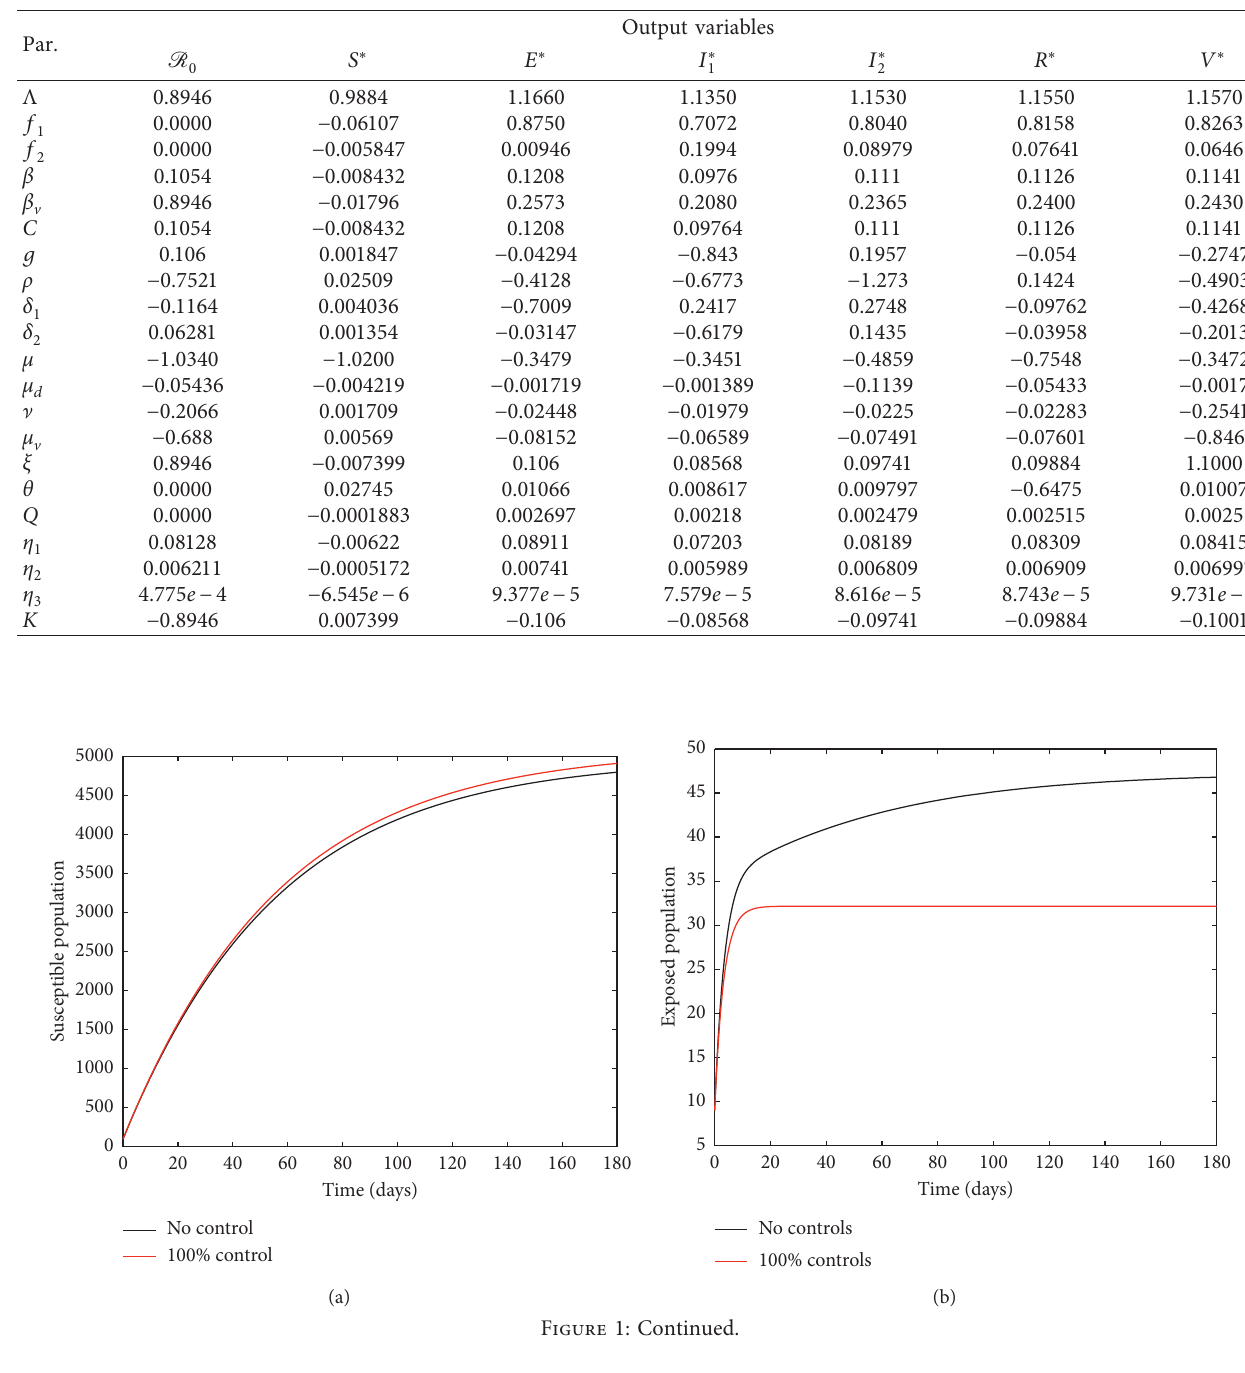
Table 2: Sensitivity indexes of R